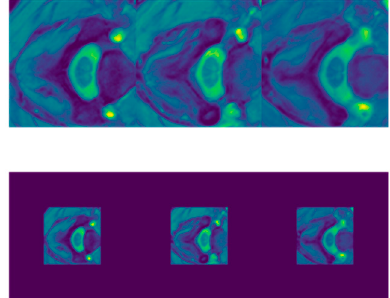
Figure 3. Slices of SCGM MRIs of subject 10 from site 1. Original image size is 100 × 100. Top row displays original images while the bottom one shows the corresponding cropped slices.